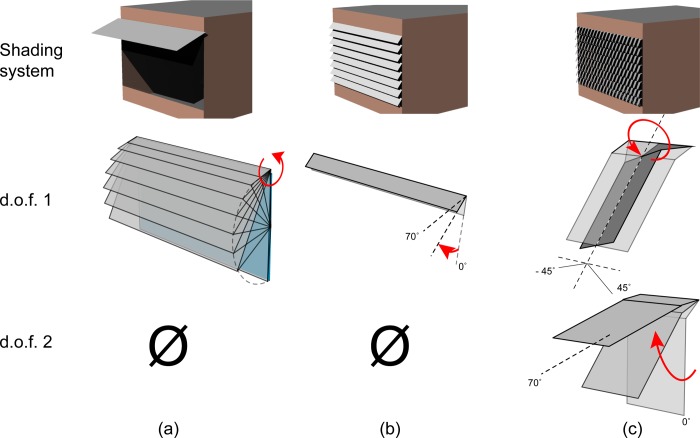
Three types of shades and their associated d.o.f. (a) Awning with roller extension (d.o.f. 1), (b) Venetian shades with slat angle (d.o.f. 1), and (c) Solar tracker with azimuth angle (d.o.f. 1) and elevation angle (d.o.f. 2)–circular arrows denote rotational actuators.